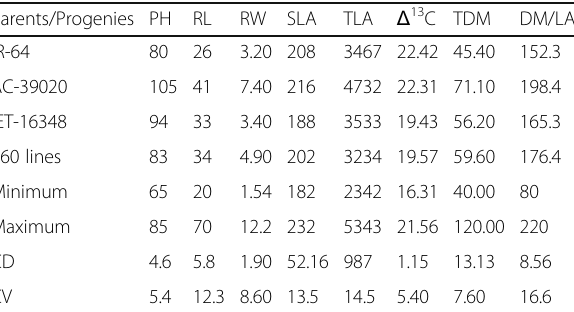
Table 5 Variability in root traits and other biometric parameters among parents and BC 3 F 3